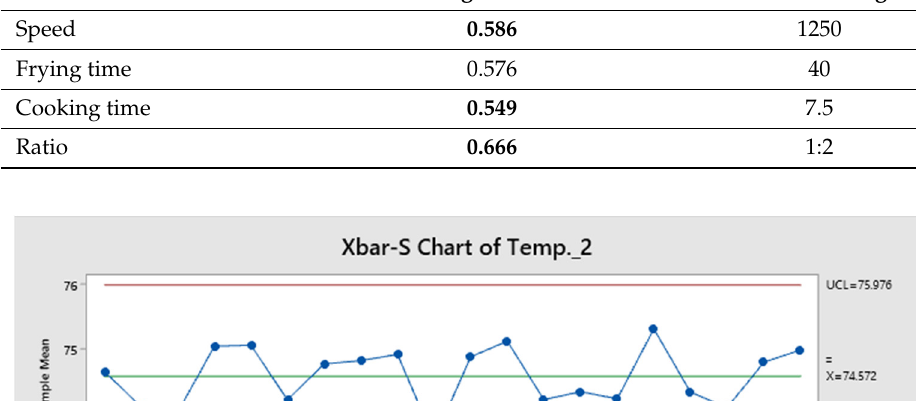
Table 16. Results for the optimization of a single response.